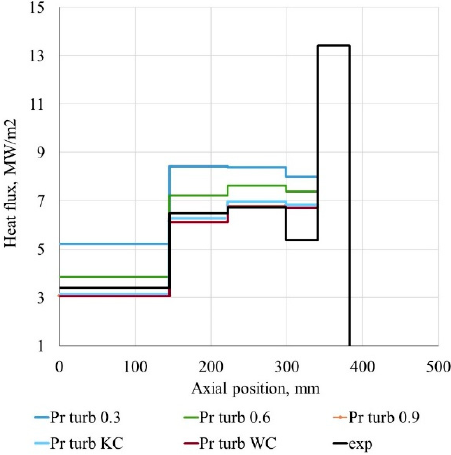
Figure 20. Segment averaged heat flux distribution.